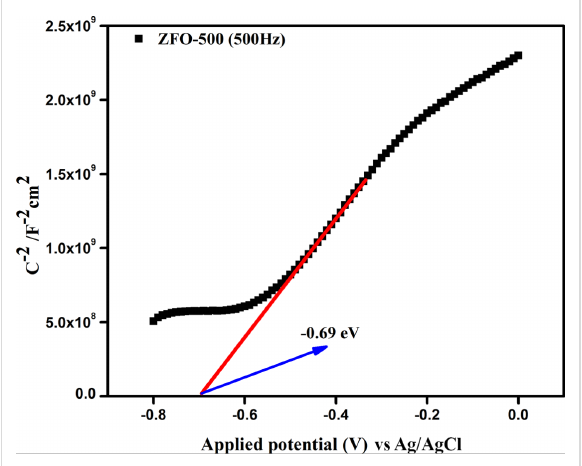
Figure 8: Mott–Schottky plot yielding the flat-band potential of ZFO- 500.